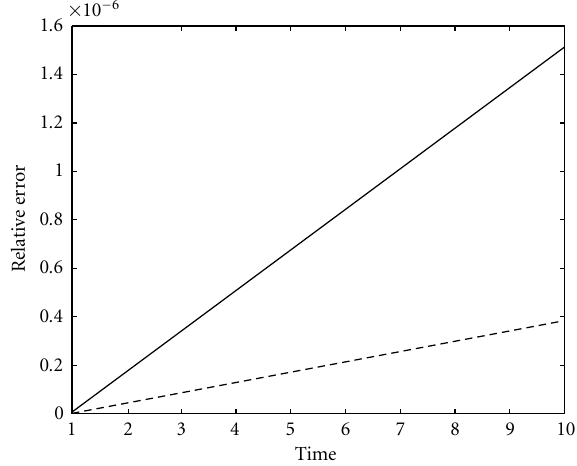
Figure 3.1. The solid line shows the accelerated RK3 scheme given in (2.9b) for (3.1). The dashed line is for the standard RK3 algorithm that uses three function evaluations. The time step for the integration is h = 0 . 01.